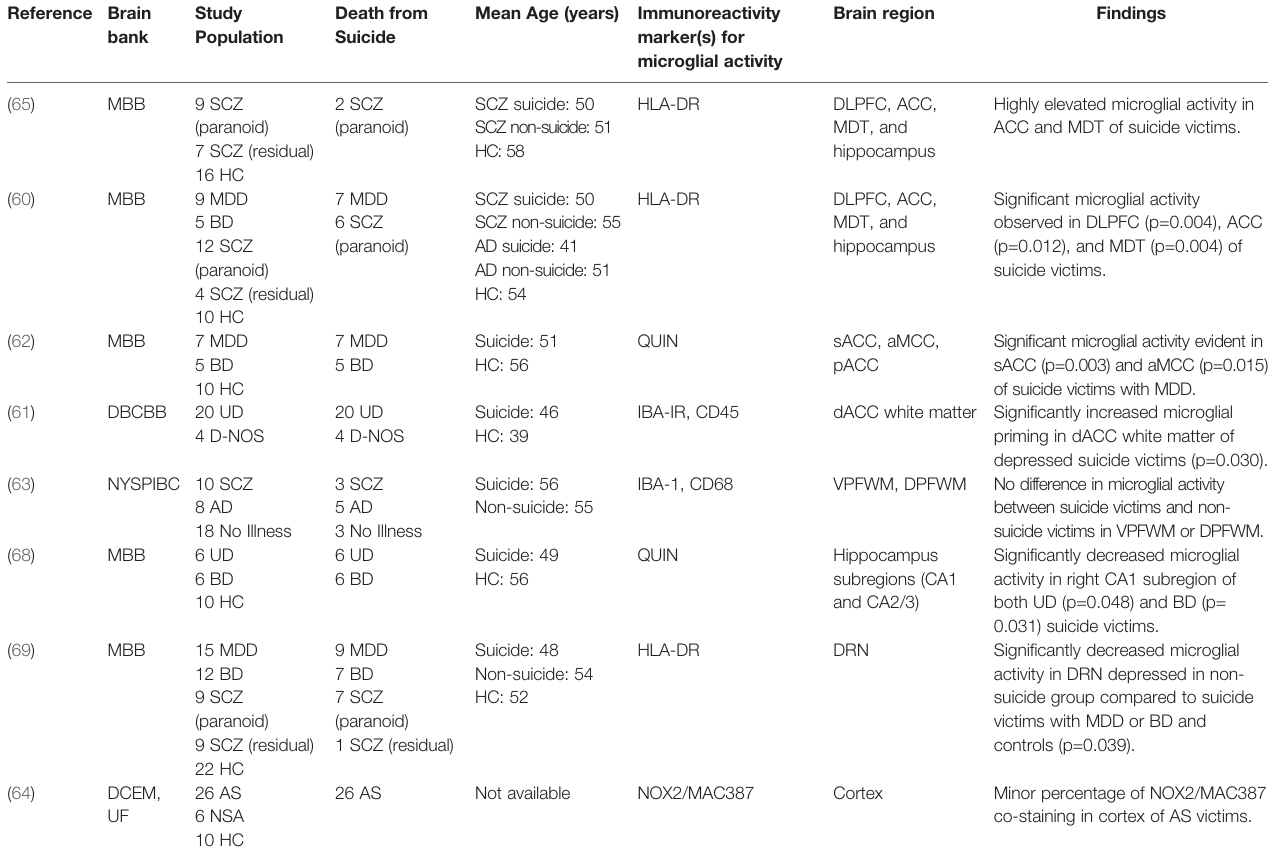
TABLE 2 | Post-mortem studies of microglial activity in SB. Reference Brain